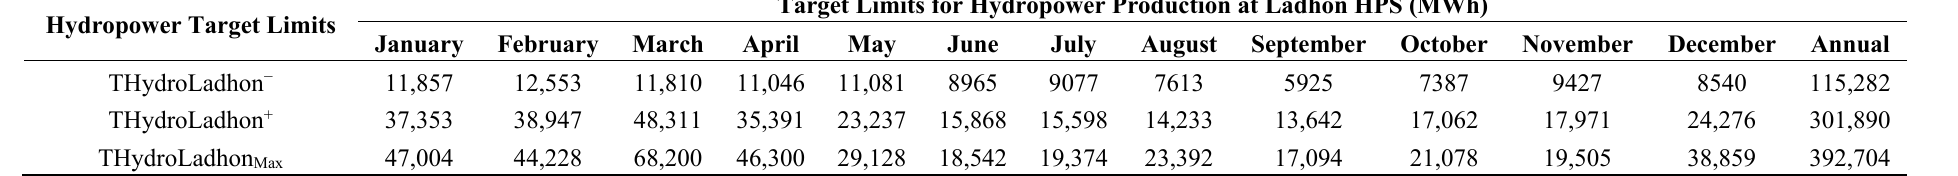
Table 2. Upper (THydroLadhon + ) and lower (THydroLadhon − ) bound of optimized target for hydropower production and the maximum allowable (THydroLadhon Max ) at the hydropower station (HPS) at Ladhon.